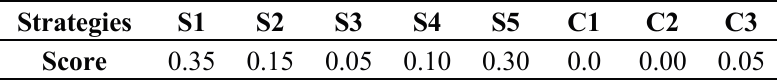
Table 3. Recommendation vector